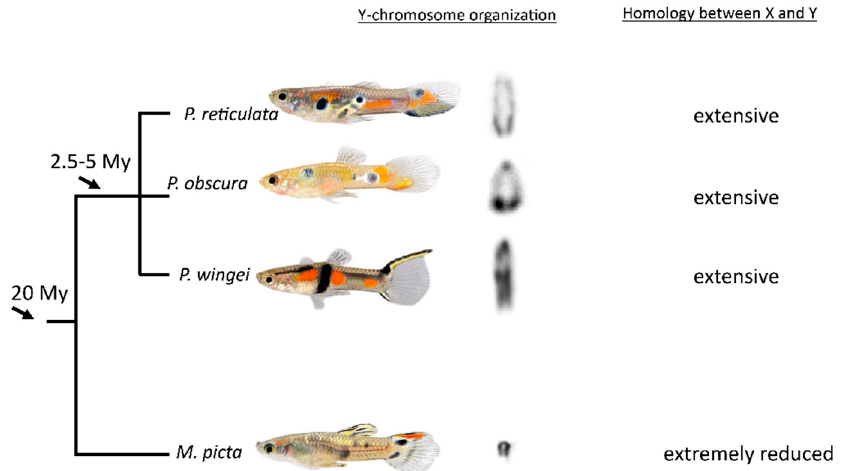
Figure 8. Dynamic evolutionary transition of Y-chromosome structure among related guppies. The cut-outs of the Y-chromosomes are from the same magnification. The phylogenetic relationship was arranged according to [11,18].